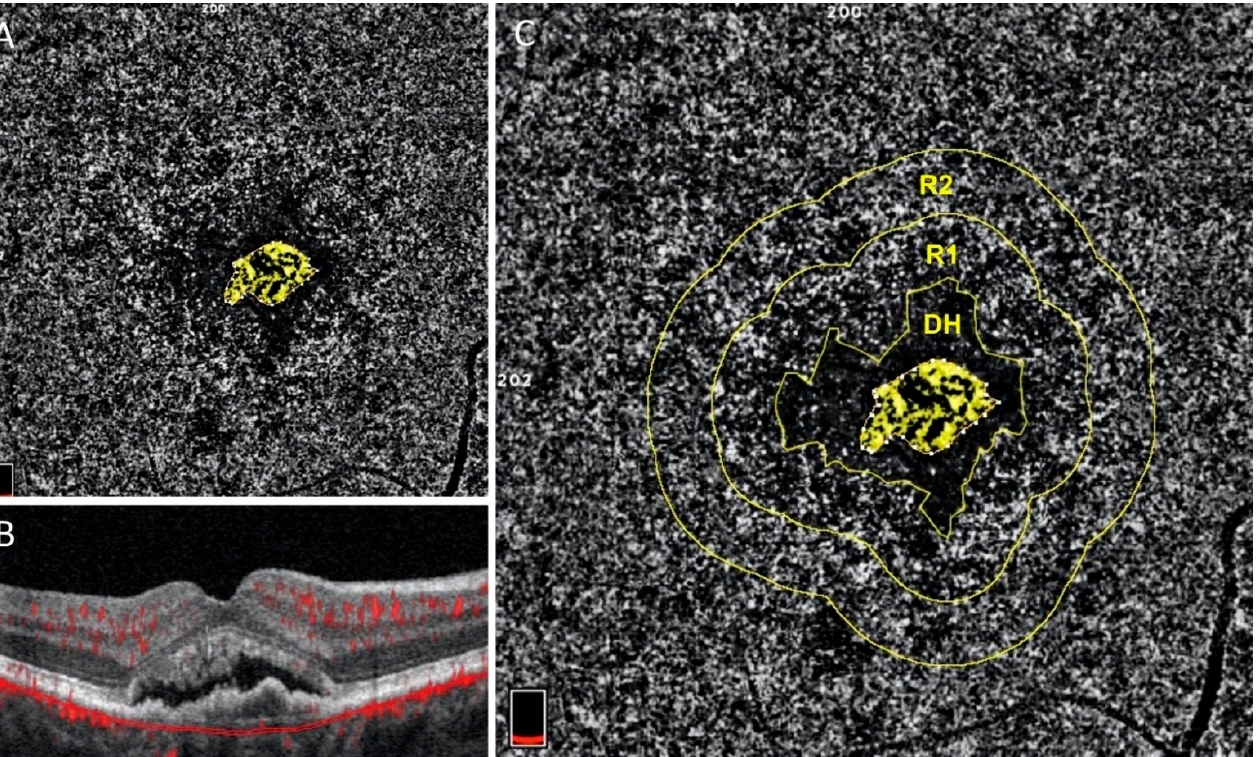
Figure 4. Courtesy of Scharf et al. 2020: Choriocapillaris flow deficits around macular neovascularization: En face choriocapillaris OCTA (A and C) and structural OCT B-scan (B) images of treatment-naïve exudative macular neovascularization (MNV). In the Scharf study, en face choriocapillaris angiograms were analyzed for the percentage of choriocapillaris (CC) flow deficits in two concentric rings, (R1) and (R2), around the peri-lesional dark halo (DH), (image C). The ring closer to the MNV (R1) exhibits significantly greater percentage of flow deficits than the more peripheral ring. Both rings exhibit significantly greater flow deficits than the same areas in age-matched normal controls [44].